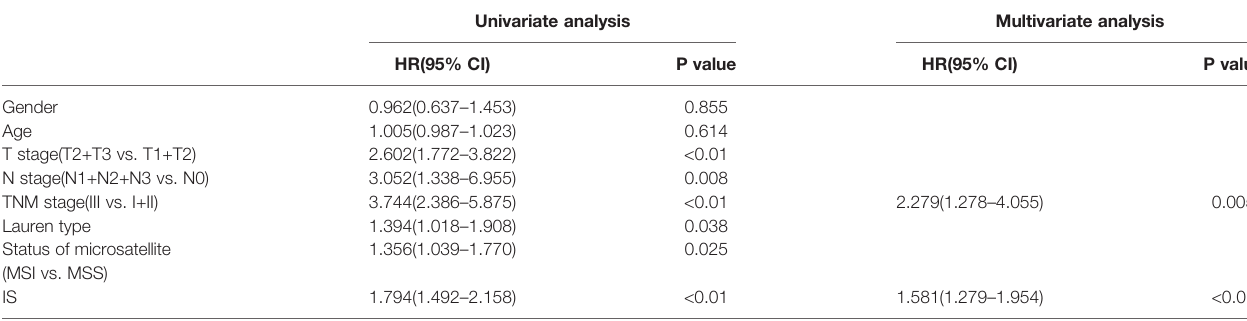
TABLE 2 | Univariable and multivariable association of IS classi fi er, clinicopathological characteristics with DFS in the training